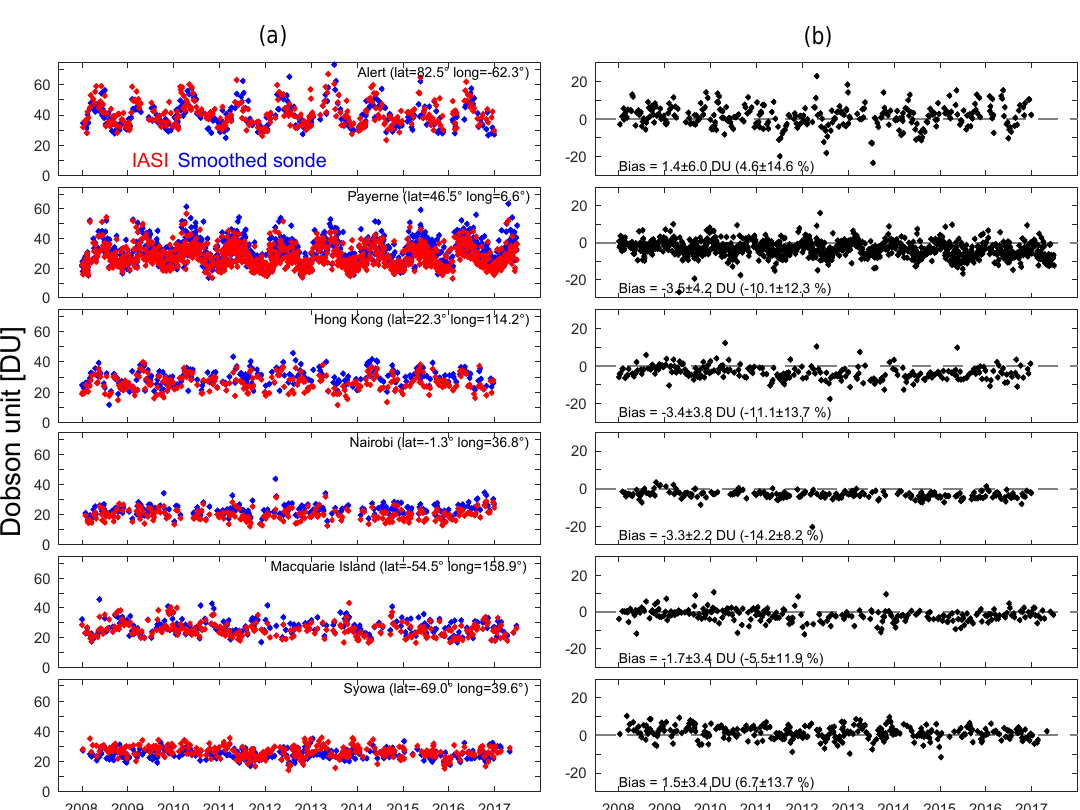
Figure 15. (a) Time series of daily IASI-A (in red) and smoothed ozonesonde (in blue) TROPO O 3 columns in Dobson units (DU) for six stations representative of different latitude bands for the period from 2008 to 2017. (b) The associated relative differences (in percent), calculated as 100 × (IASI − SONDE) / SONDE, including the mean bias and the 1 σ standard